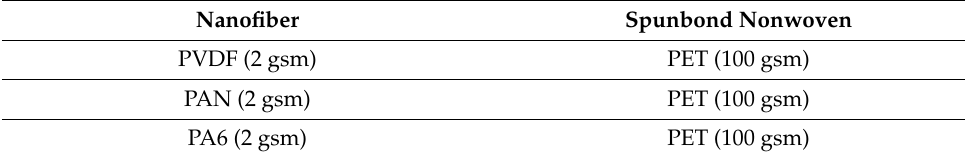
Table 1. Types of polymeric nanofibers and support layers.